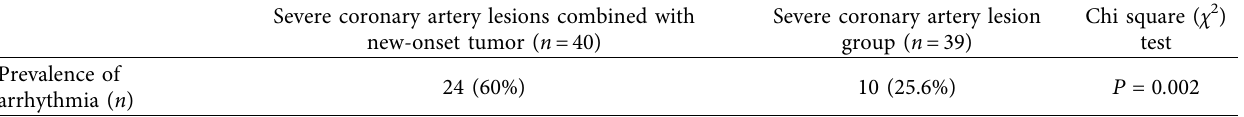
Table 2: Comparison of prevalence in arrhythmia between two